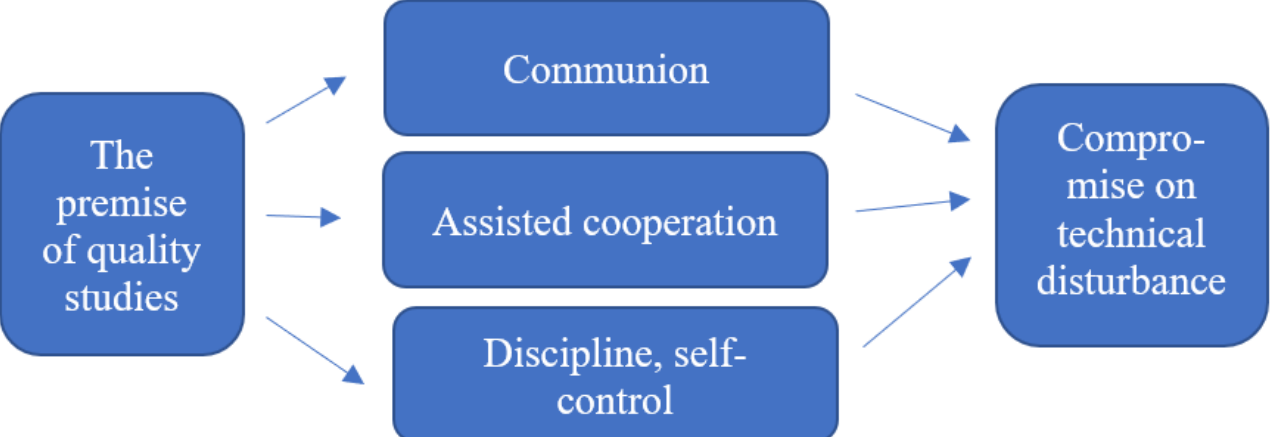
Figure 1. Relationships between research